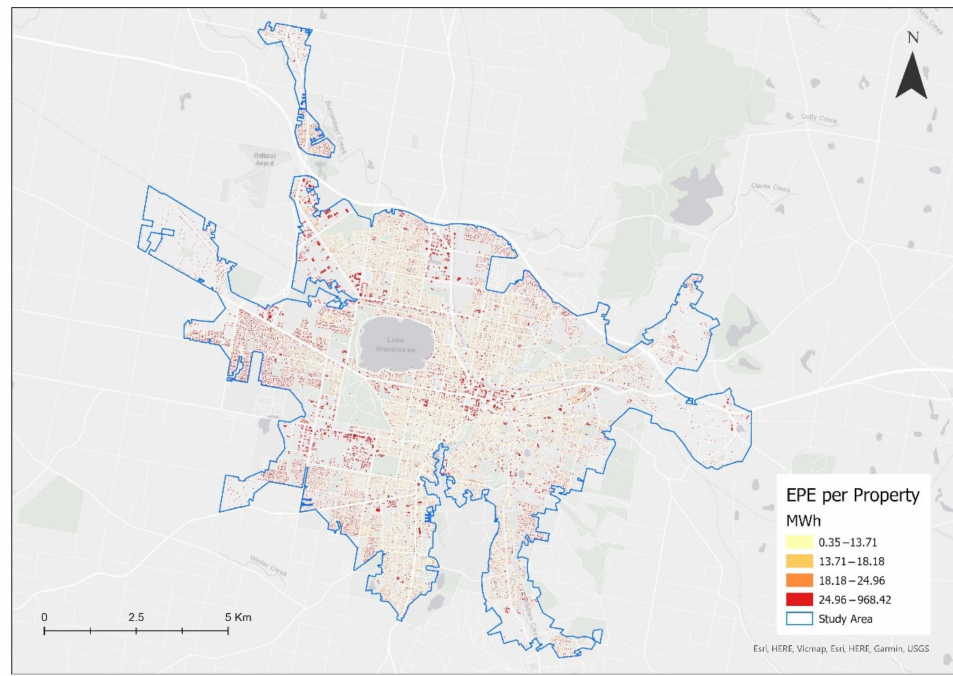
Figure 8. Spatial distribution of the EPE.